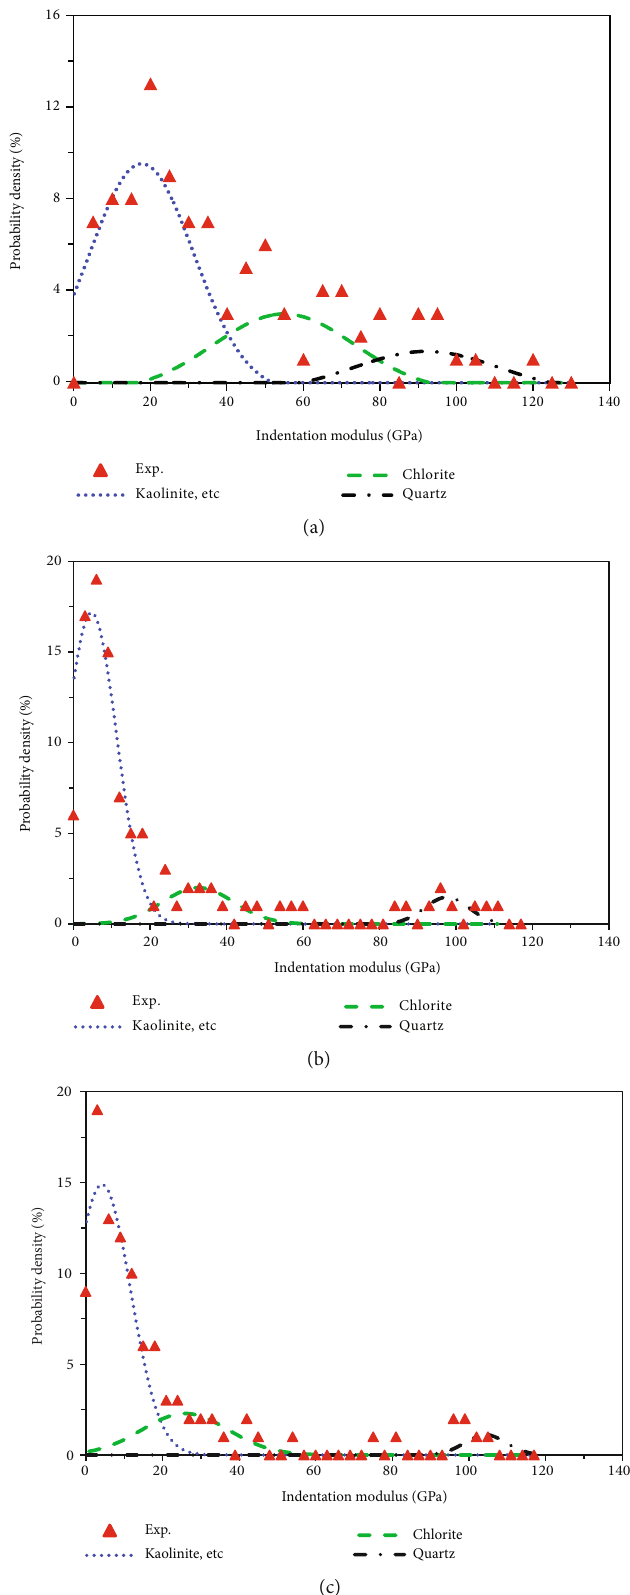
Figure 14: Fractions of each Gaussian probability density of indentation modulus of (a) NM-1, (b) NM-2, and (c)